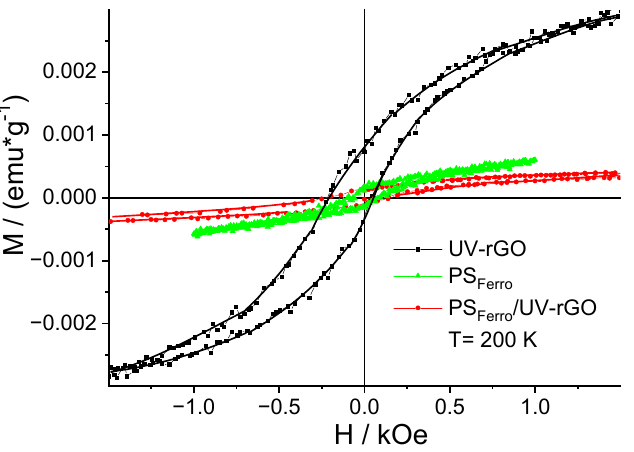
Figure 9. Magnetic field dependences of the specific magnetic moment for UV-rGO flakes (black curve), PS Ferro (green curve) and a composite (red curve) based on magnetic PS Ferro at T = 200 K.